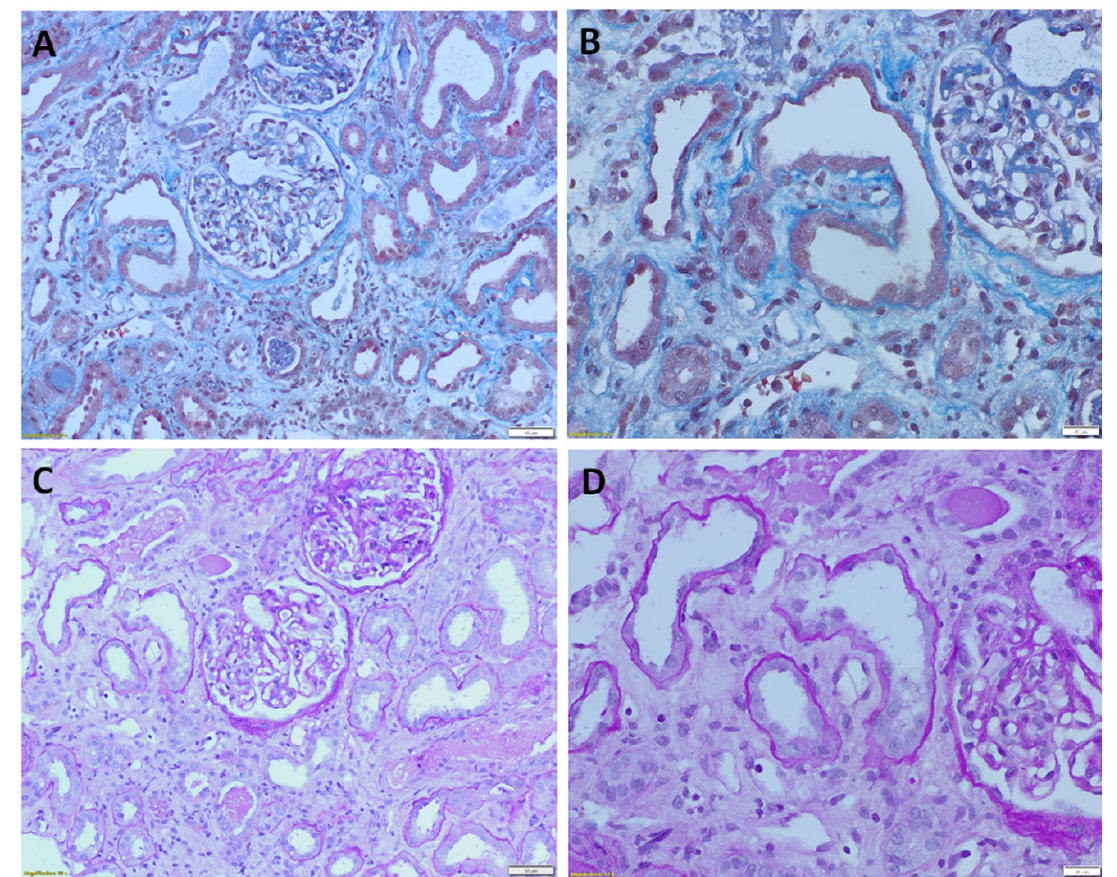
Figure 2. Morphology of acute kidney injury in human biopsy samples. Dilatation of proximal tubuli with flattened epithelium which are separated with widened interstitium due to edema. ( A ) Massone-trichrome stain, ×200. ( B ) Massone-trichrome stain, ×400. ( C ) PASS stain, ×200. ( D ) PASS stain, ×400.